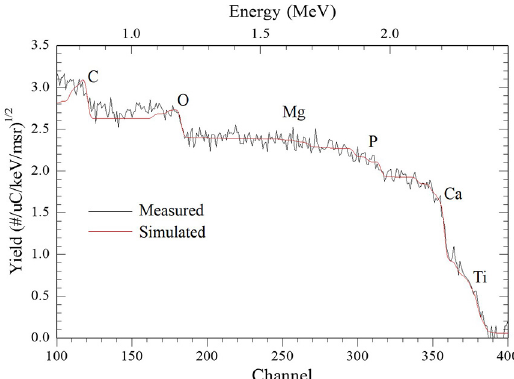
Figure 6. RBS spectrum (measured and simulated) of the sample treated by PEO with C = 0.06 M. M